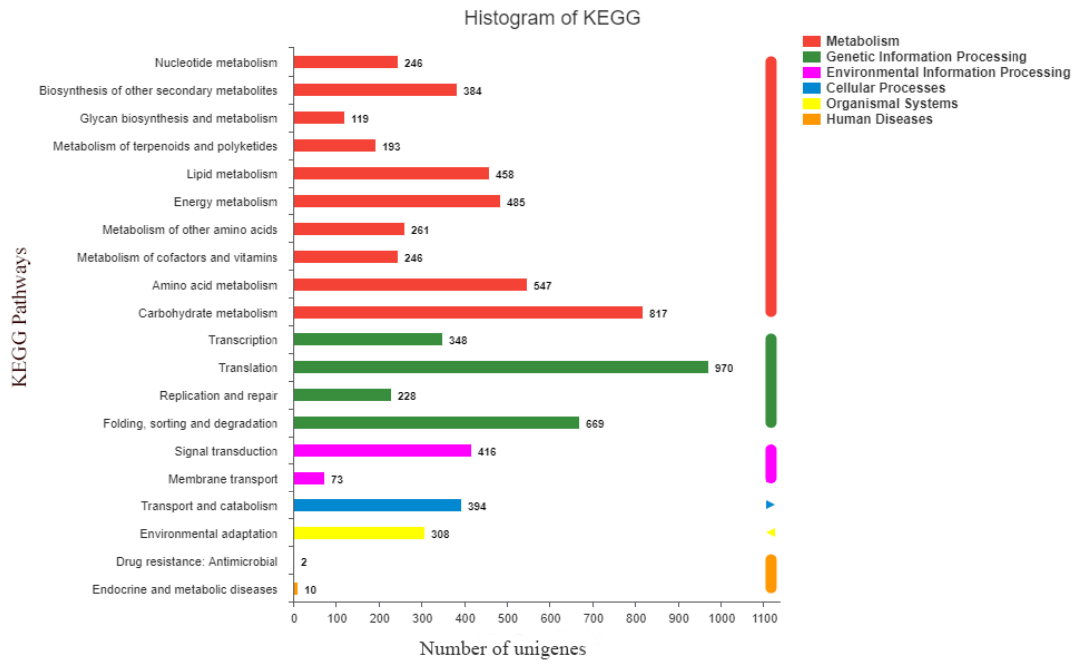
Figure 2. Kyoto Encyclopedia of Genes and Genomes (KEGG) function classification results of the annotated unigenes in resistant Beckmannia syzigachne . The x and y axes indicate KEGG pathways and the number of genes, respectively.